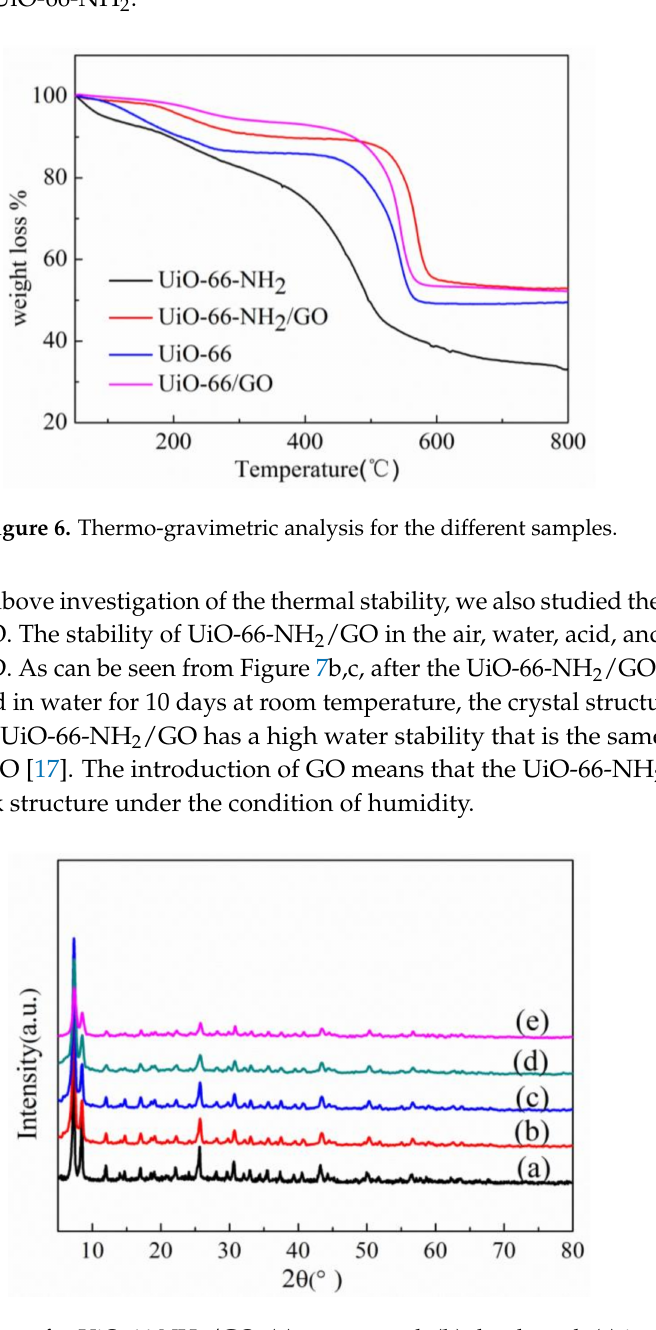
Figure 7. XRD patterns for UiO-66-NH 2 /GO: ( a ) as-prepared; ( b ) desolvated; ( c ) in air for 30 days; ( d ) soaked in water for 10 days; ( e ) immersed in in HCl solution (pH = 1) for 2 h; and, ( f ) NaOH solution (pH = 14) for 2